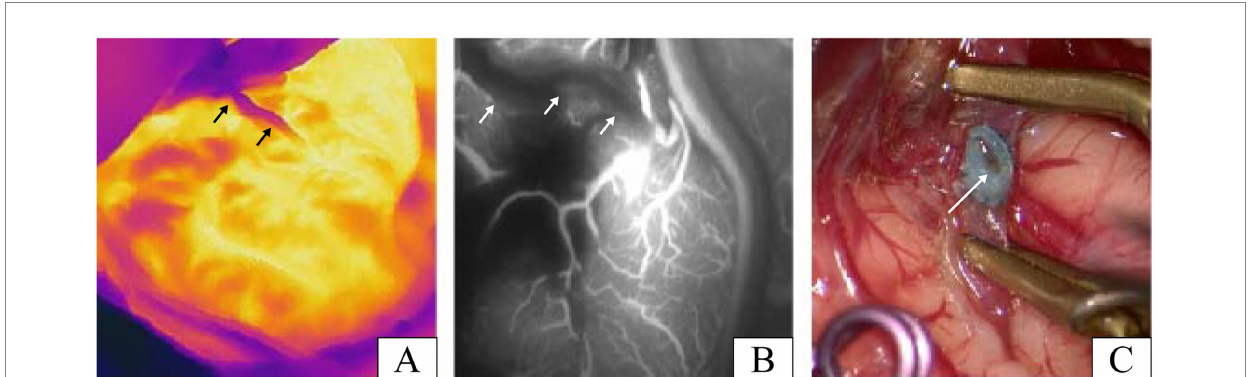
FIGURE 4 A patient with inadequate patency of vascular anastomosis in our study. (A) Infrared thermographic results of this patient after the release of the vascular clip (the black arrows denote the STA). (B) Image results of the ICG-VA after the release of the vascular clip in this patient (the white arrows indicate the STA). (C) Thrombosis was found after reopening the recipient artery and was the cause of the insufficient patency of the vascular anastomosis in this case (the white arrow shows the thrombosis in